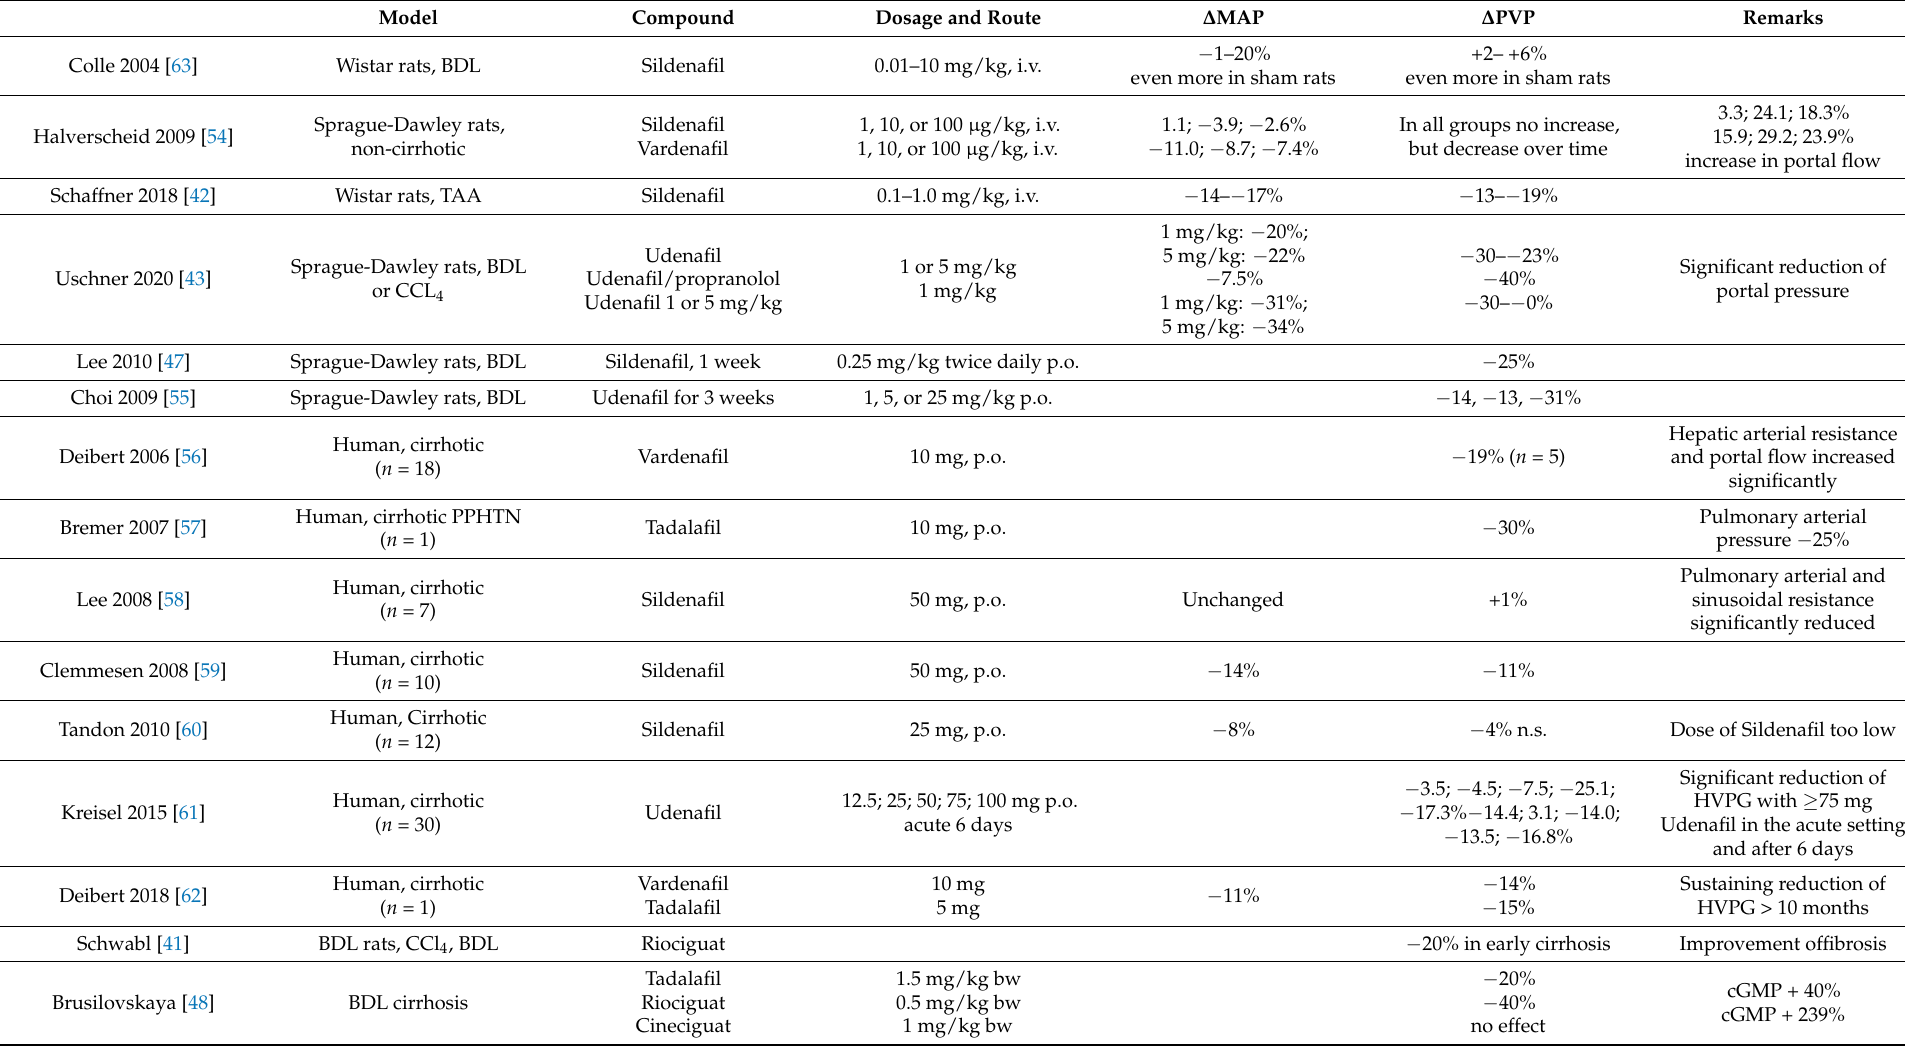
Table 1. Effect of PDE-5 inhibitors and sGC modulators on portal pressure, Kreisel and Schaffner et al. (2020)